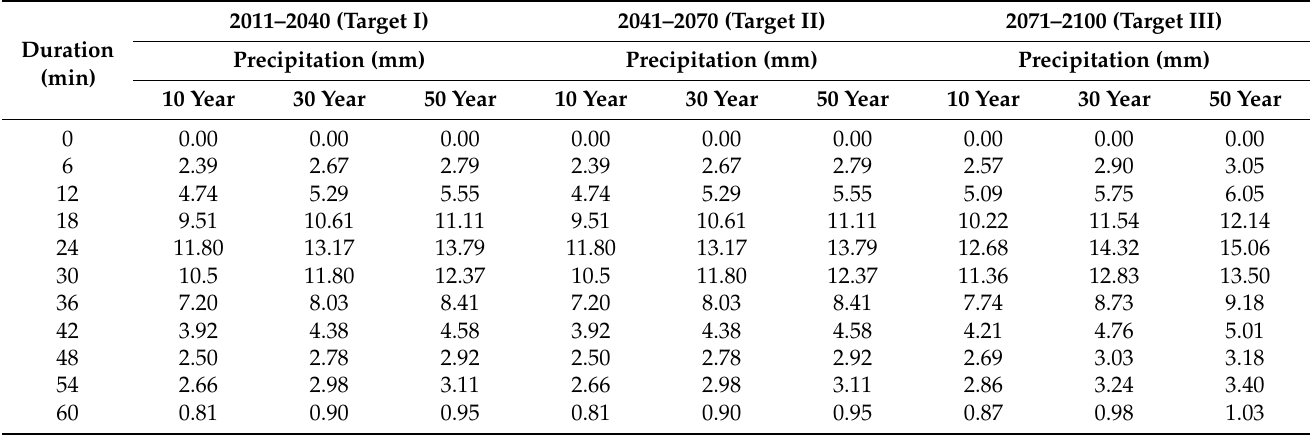
Table 3. Predicted probable precipitation for three target periods for the duration of 1 h in Changwon City